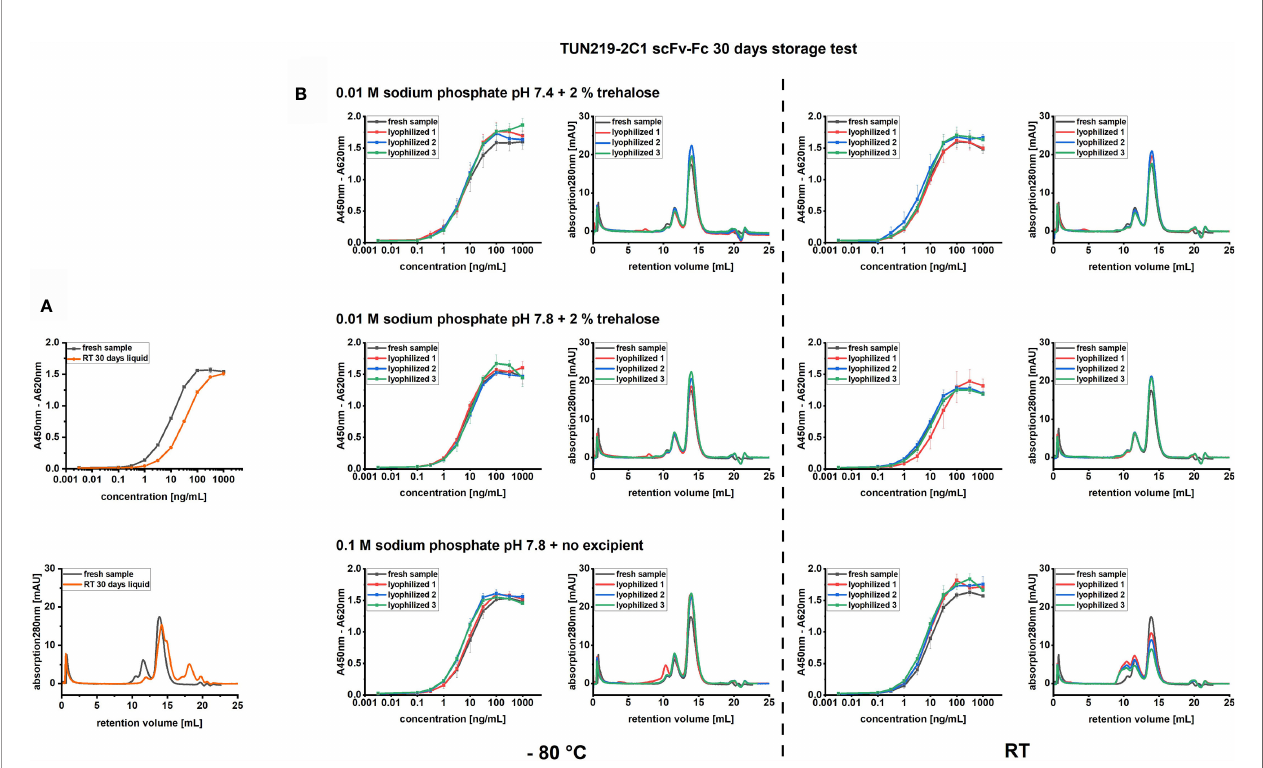
FIGURE 2 | Model antibody storage test. (A) TUN219-2C1-hFc antibody after storage for 30 days at RT in 1 x PBS solution was compared with the fresh antibody in SEC and indirect ELISA, where 100 ng immobilized antigen were incubated with TUN219-2C1-hFc in a concentration range spanning from 3.16 pg/mL to 1 µg/ mL. (B) Differently formulated lyophilizates of TUN219-2C1-hFc were stored at RT or - 80°C for 30 days and afterwards compared with the fresh antibody in SEC or indirect ELISA. Data derived relative af fi nity values (EC 50 ) and monomer species percentages are shown in Supplementary Table 2